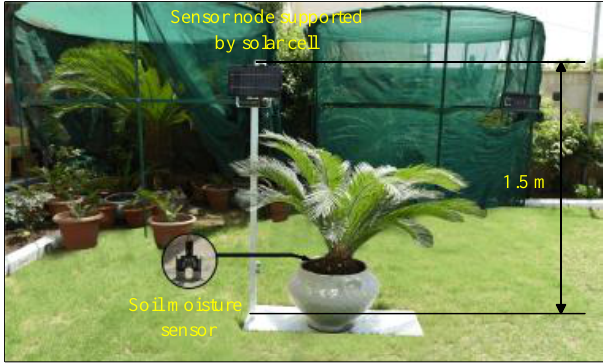
Figure 3. Sensor node installed at the farm.